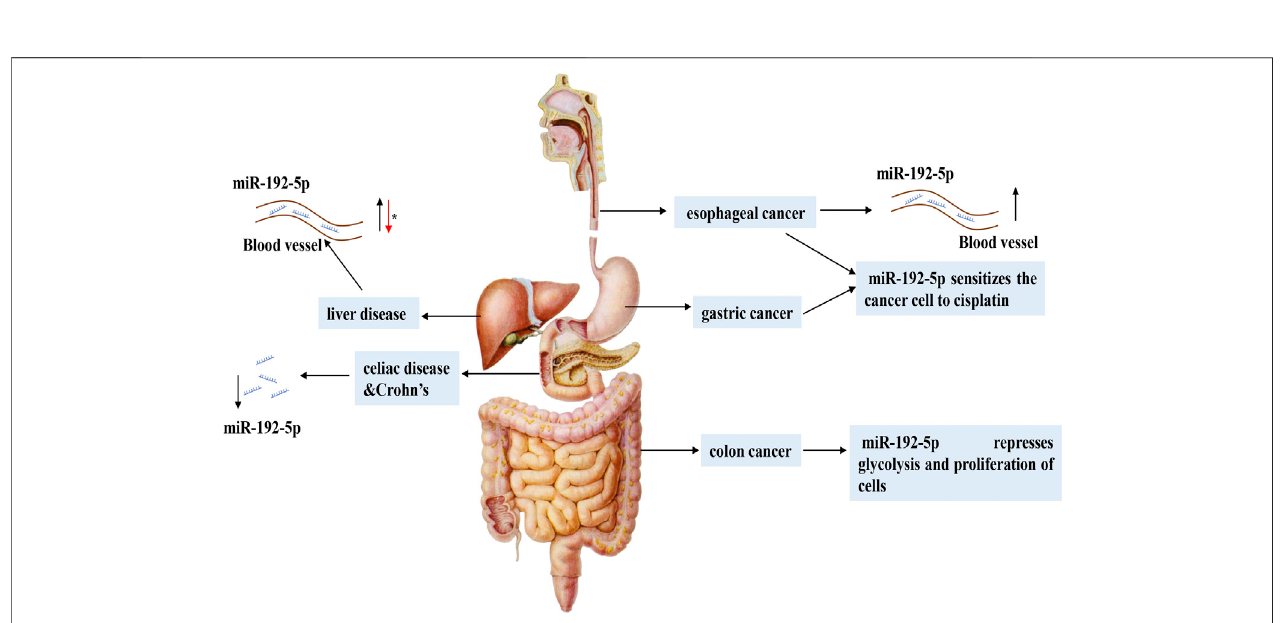
FIGURE 3| The expression and regulatorymechanism ofmiR-192-5p in digestive system. In different digestive system diseases, theexpression of miR-192-5p is fl exible. In various liver diseases, miR-192-5p exhibits different expression levels and exerts versatile function. The asterisk (*) represents the controversial role of miR-